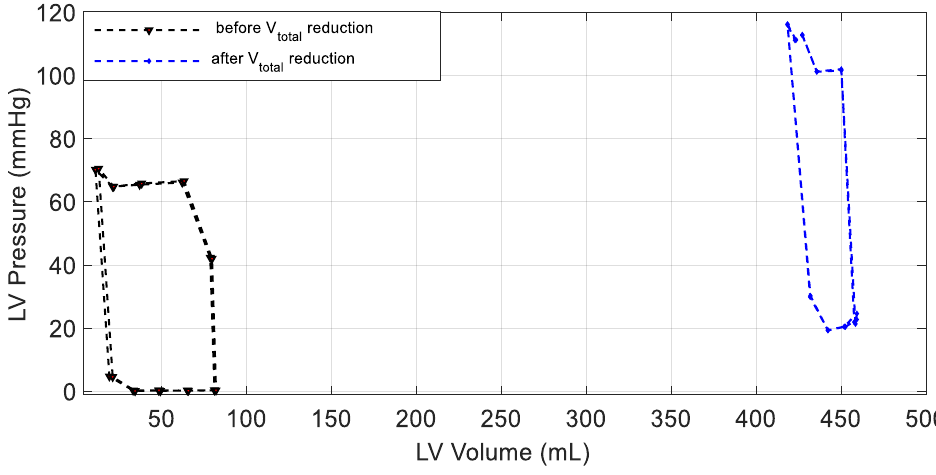
Figure 5. Hemodynamic characteristics for a controller at constant